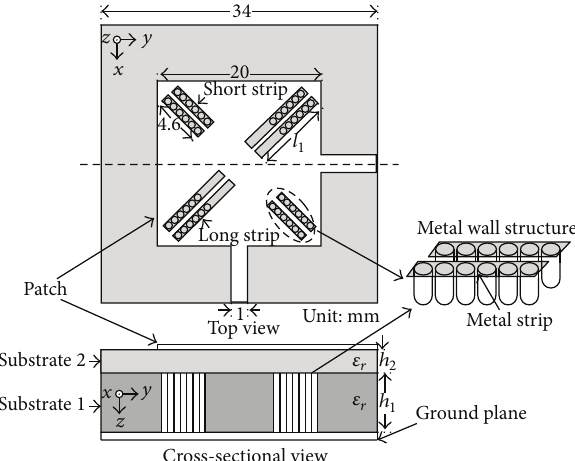
Figure 1: Proposed dual-mode patch filter with the metal wall structures.